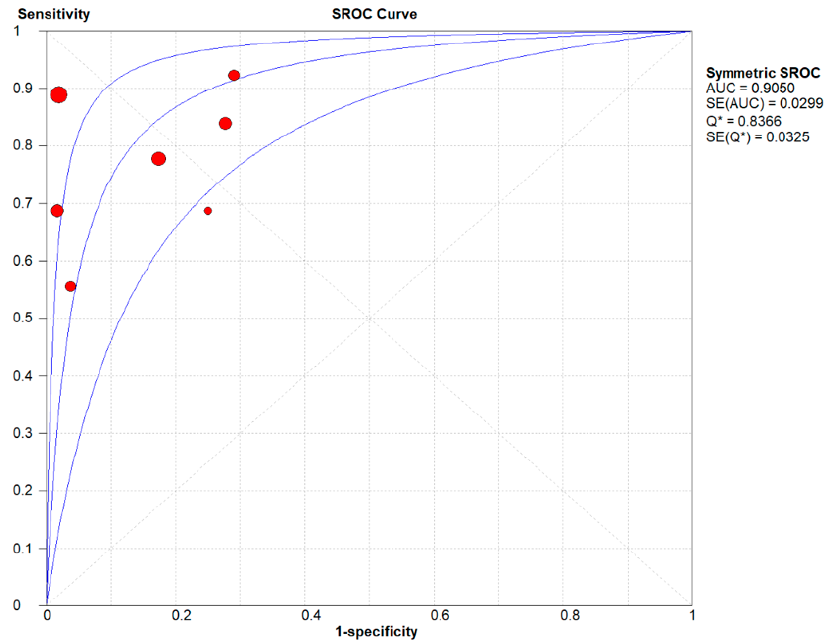
Figure 4. Summary receiver operating characteristic curve for the diagnosis of lymph node tuberculosis in children by Xpert.